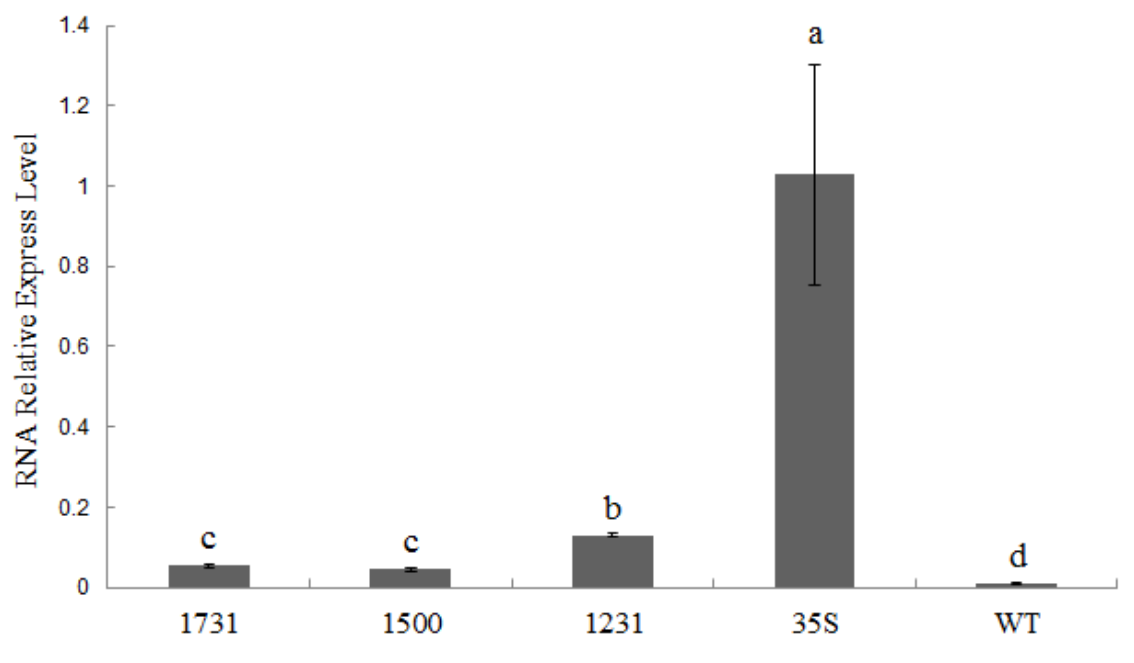
Figure 7. Transcriptional level of GUS in transgenic tobacco leaves. Data was shown as average ± S.E. of 6 independent transgenic lines. Letters above the columns indicate statistically significant differences at p < 0.05 level. Relative transcript levels were calculated using the 2 −ΔΔ Ct method [29] with Actin as a housekeeping